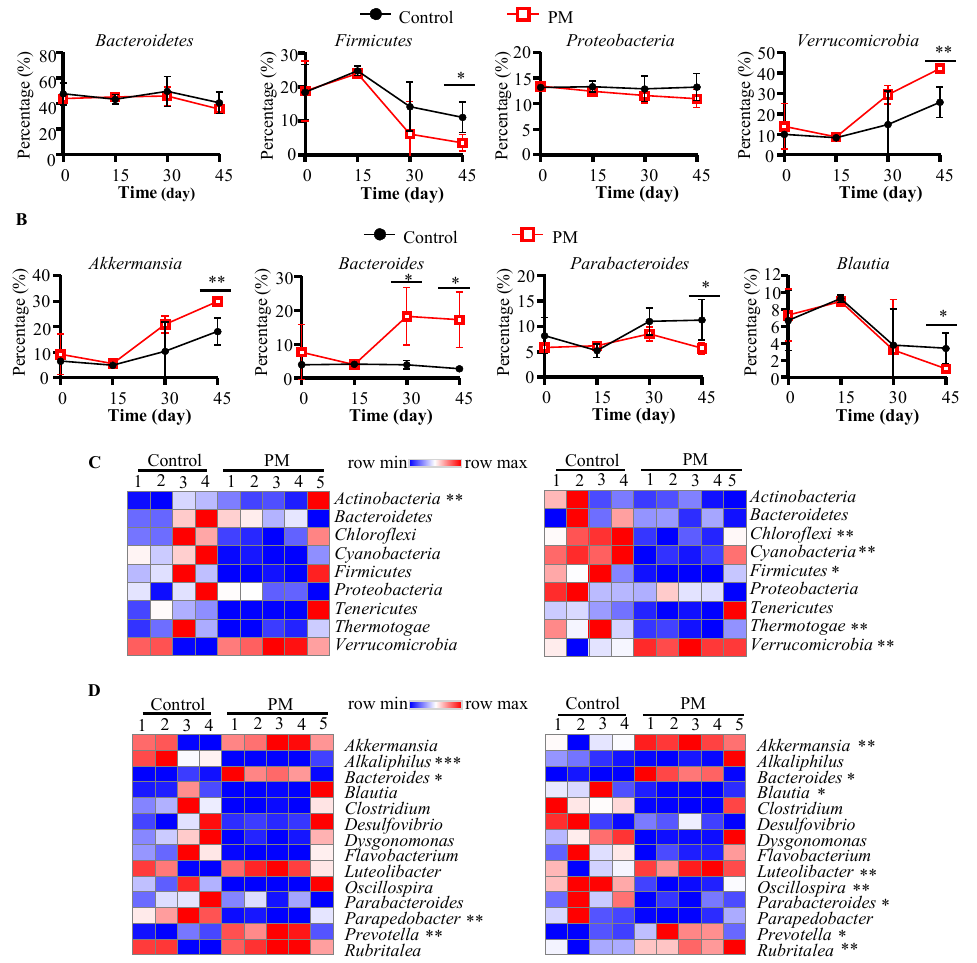
Figure 2. Time-dependent changes of fecal microbiota in control and PM-treated mice. Relative abundances of microbial communities at the Phylum and Genus levels were determined in fecal samples collected from control ( n = 4) and PM-treated ( n = 5) mice before (day 0) and various time points (days 15, 30, and 45) during the treatment. Analysis of time-dependent changes in major phyla ( A ), and genera ( B ) between control and PM-treated mice are shown. Relative abundances of microbial communities at the phylum ( C ) and genus ( D ) levels in fecal samples collected from control and PM-treated mice on day 30 (left panels) and day 45 (right panels) are also shown. Heat maps were generated using Morpheus (Broad Institute, Cambridge, USA), p -values by unpaired t -test. p -values were determined using unpaired t -test on GraphPad Prism. * p < 0.05, ** p < 0.01 and *** p <